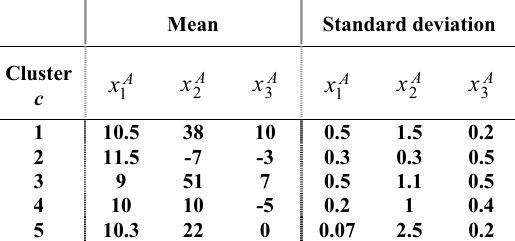
, A x and A x 1 3 2